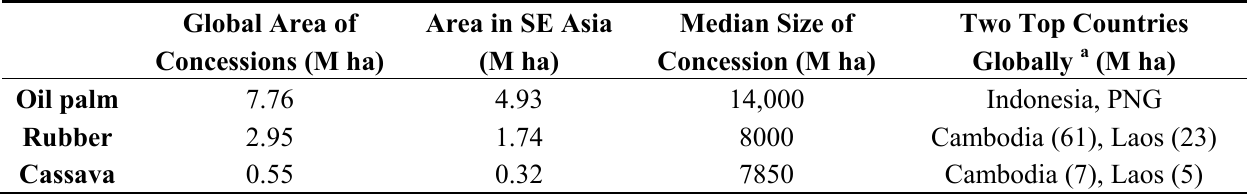
Table 2. Summary of land concessions for oil palm, rubber and cassava, 2001–2013. Source: